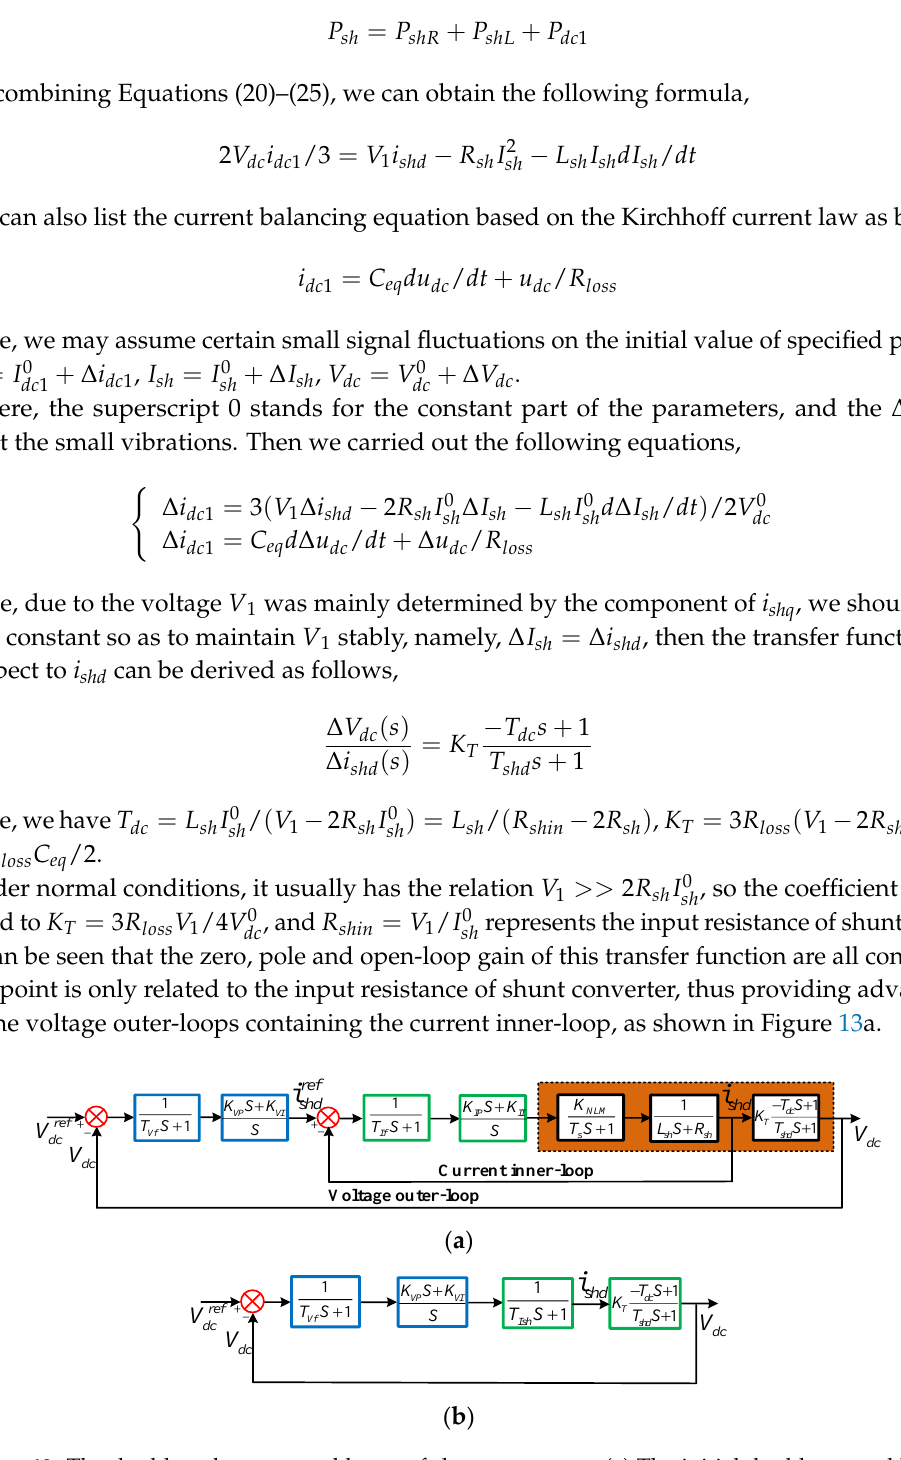
Figure 13. The double voltage control loops of shunt converter. ( a ) The initial double control loops; ( b ) The simplified unity-feedback voltage control loop.